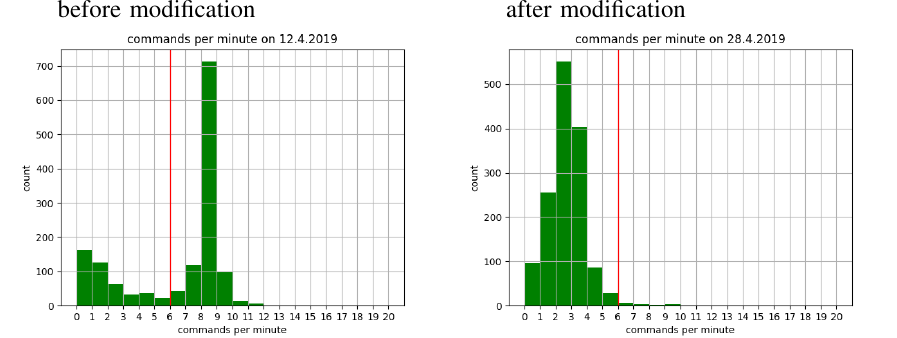
Figure 4. Histograms of the number of requests per minute before (left) and after (right) modification of ARC-CE commands. Before the change, the ARC-CE usually exceeds 6 PBS requests per minute limit. After the change, it is